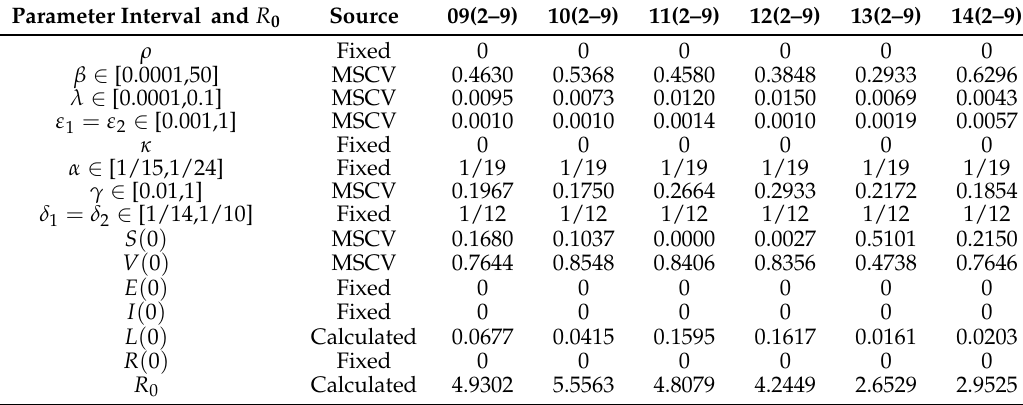
Table A1. Estimation of parameters and the basic reproduction number of the first half of the year (FHY, e.g., 09(2–9) stands for February to September of 2009, and MSCV stands for the minimum sum of chi-square value.) from 2009 to 2014.